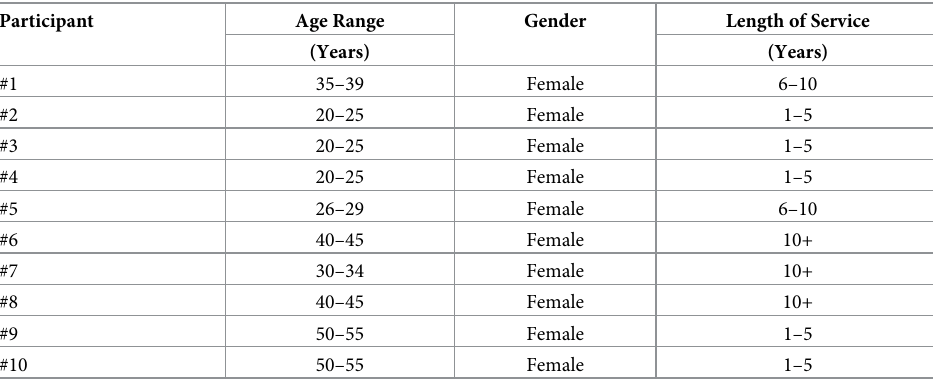
Table 1. Participant